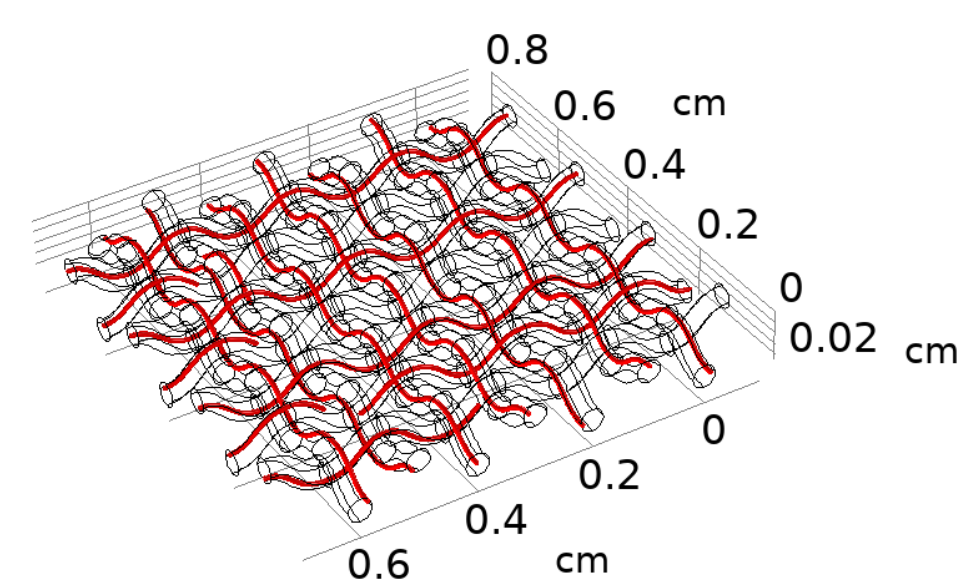
Figure 3. A three-dimensional curvilinear coordinate system for a single fiber.